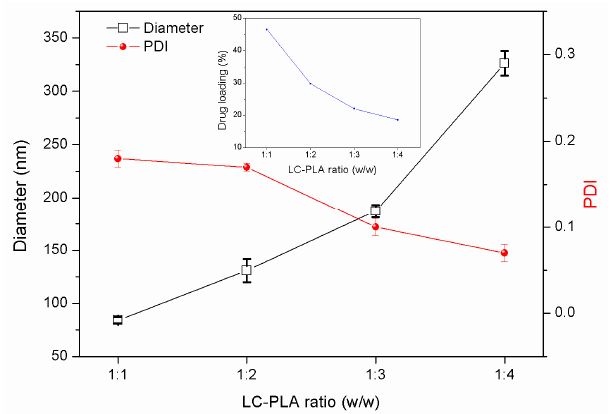
Figure 6. Particle size, size distributions, and LC loading capacities of PLA nanoparticles prepared under different LC-PLA ratios (PVA concentration was 2%, water–oil ratio was 4:3, PLA concentration was 133 g/L, and the amount of LC was constant).